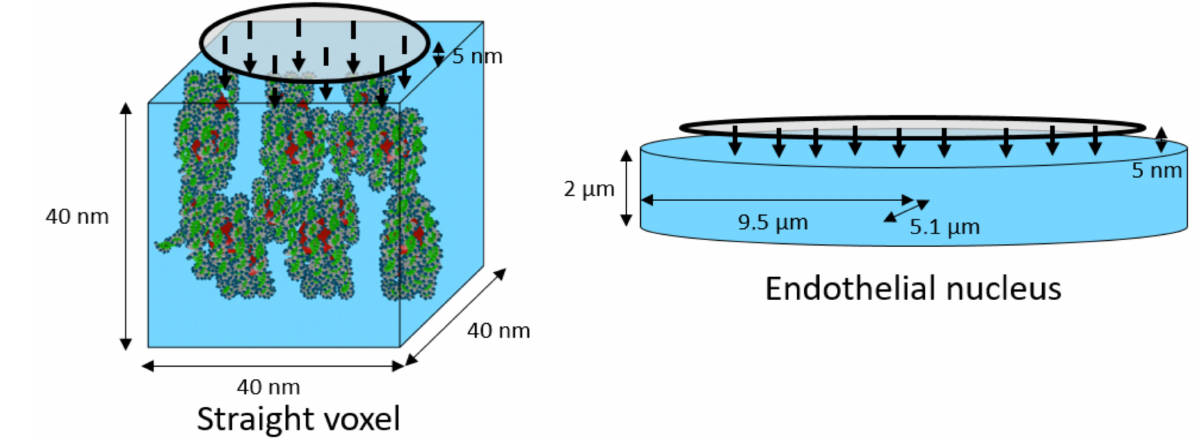
Figure 8. Geometry of simulated irradiations for the irradiation of a single voxel ( left ) and for the irradiation of a HUVEC cell nucleus model ( right ) [20] containing the DNA geometry (not shown